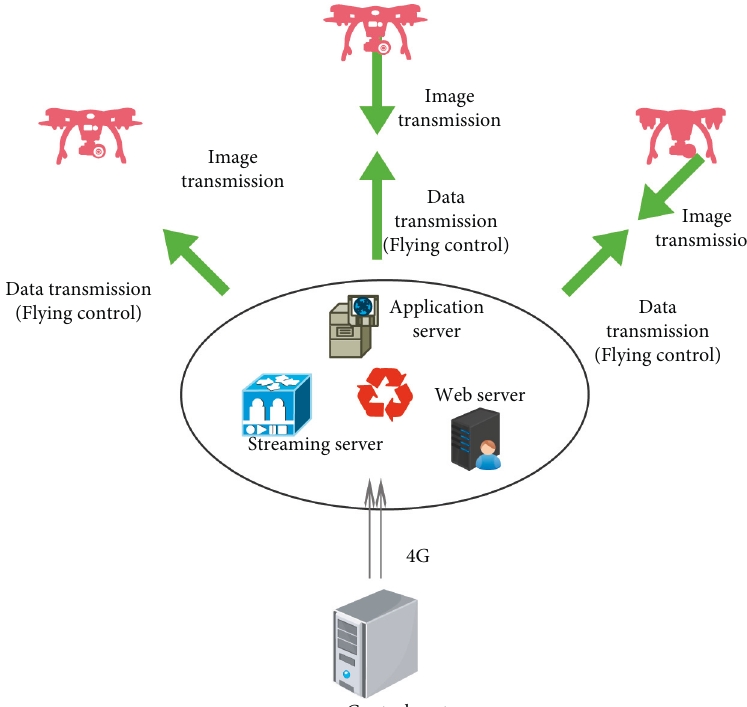
Figure 9: The flow of the UAV intelligent control system based on machine vision and multiagent